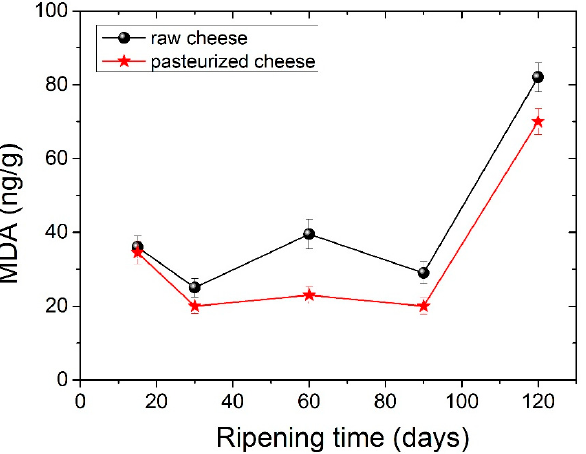
Figure 4. Lipid oxidation (mg MDA g − 1 ) changes during ripening for raw cheese and pasteurized cheese.